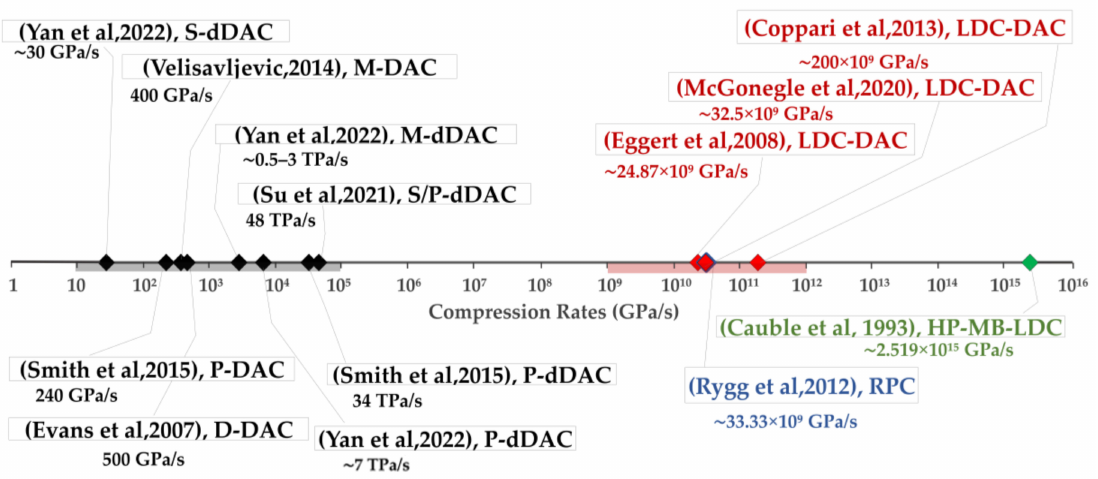
Figure 7. Compression rate of several DAC methods including; Stepper motor- dynamic (S- dDAC) [227], a piezoelectric driven (P-DAC) [228], a standard gas-Membrane (M-DAC) [229], dynamic (D-DAC) [225], gas Membranes dynamic (M-dDAC) [227], a Piezoelectric driven step compression dynamic (P-dDAC) [227,228], Static and dynamic (S/P-dDAC) [226] in comparison to LDC-DAC (Red) [30,31,47], ramped pulse compression (RPC) (Blue) [49], and HP–MB–LDC (Green)